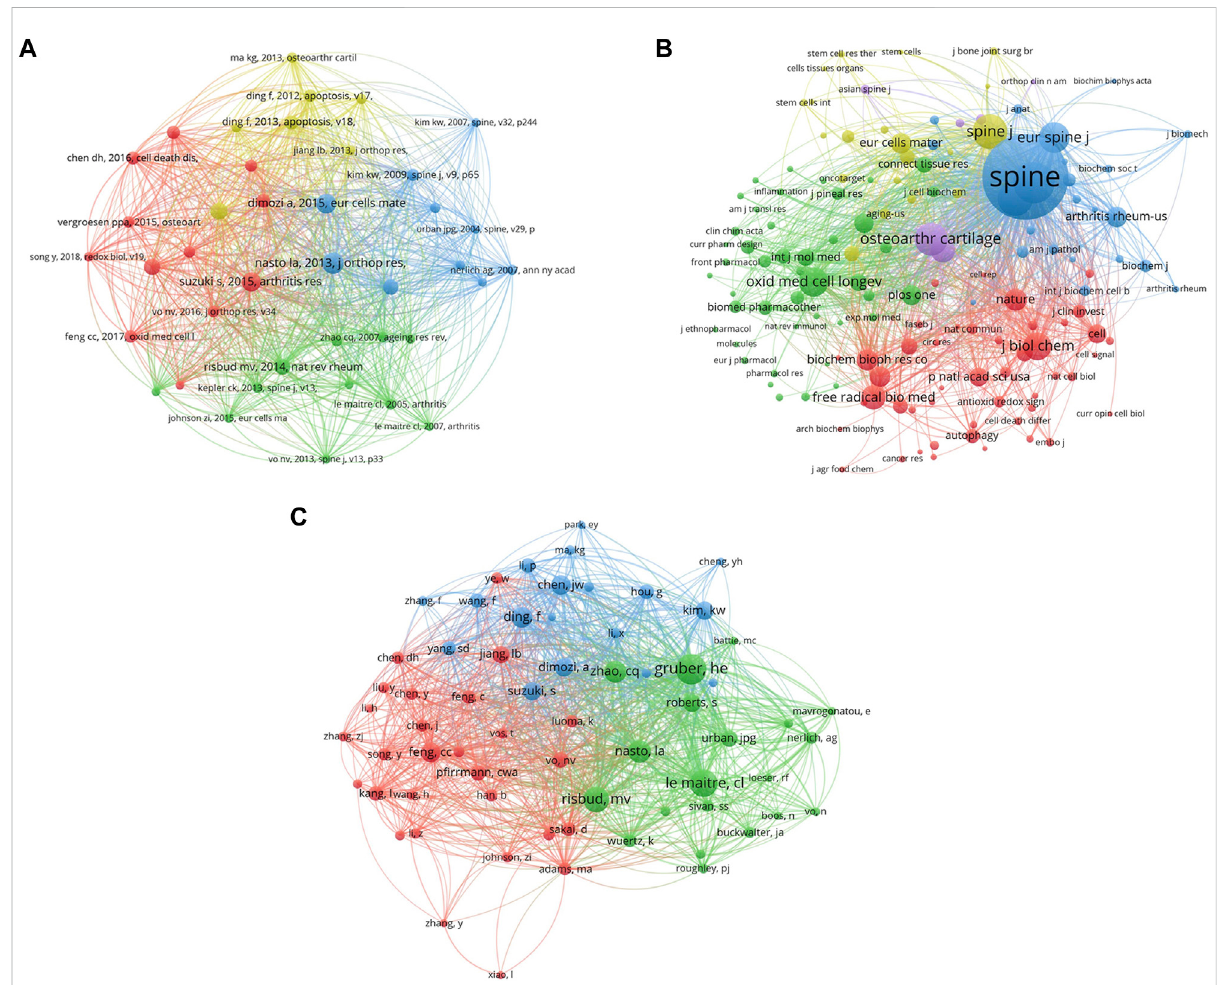
FIGURE 4 The co-citation analysis of (A) references, (B) journals, and (C) authors on oxidative stress in intervertebral disc degeneration. (A point in the fi gure represents one reference, journal, and author, respectively. The color of the point represents different clusters, and the size of the point represents the number of citations for each reference, journal, and author, respectively. The more the number, the larger the point. The connection between the two points represents two papers are jointly cited by another paper, and the length of the connection between the two points represents the correlation between two articles. The shorter the line, the stronger the